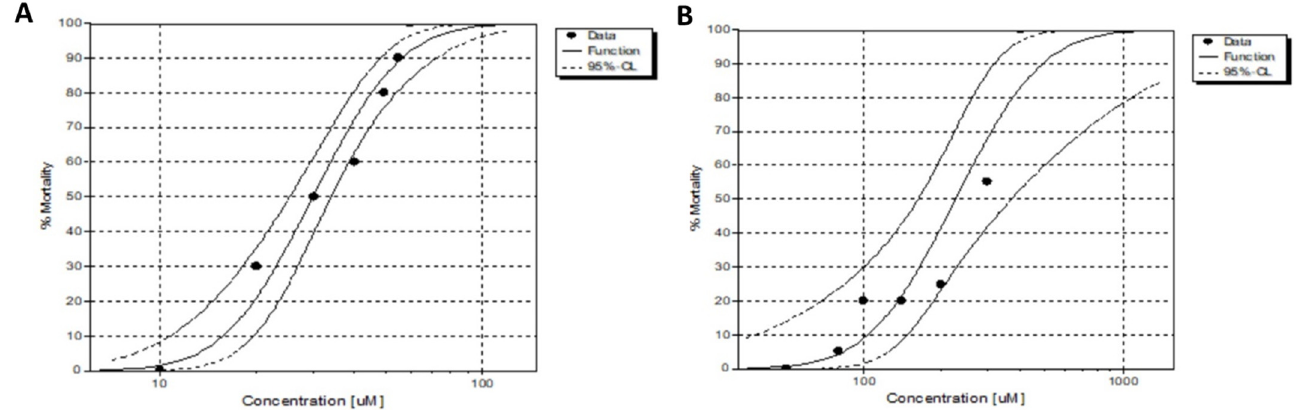
Figure 14. Mortality concentration–effect curve. ( A ) Concentration–effect curve showing the influence of JHOR10 on the mortality of the zebrafish observed after 96 h. ( B ) Concentration–effect curve showing the influence of JHOR11 on the mortality of the zebrafish observed after 96 h. HCT116 human colorectal cancer cell line was incubated in standard conditions (37 ◦ C and 5% CO 2 ) until a confluence of 80% was reached. Afterwards, the cells were concentrated and labelled with DiI and injected into the circulation (Duct of Cuvier) of 48 hpf zebrafish embryos to assay the proliferation in vivo of the cells exposed to JHOR11 (80 µ M). JHOR11 was dissolved in the embryo water at 1 dpi (days post-injection) for the embryos to recover tissue (CHT), and was maintained until the end of the experiment at 4 dpi. Imaging of the embryos was performed at 1 dpi and 4 dpi to quantify the fluorescence and area of the cells in the tail of the embryos, where cells invade and grow, and measure their proliferation over time to assess the inhibitory effect of JHOR11 over the cells. the circulation of the zebrafish embryos, decreasing the proliferation by 45% (* p < 0.01) at 4 dpi compared to the control condition (Figure